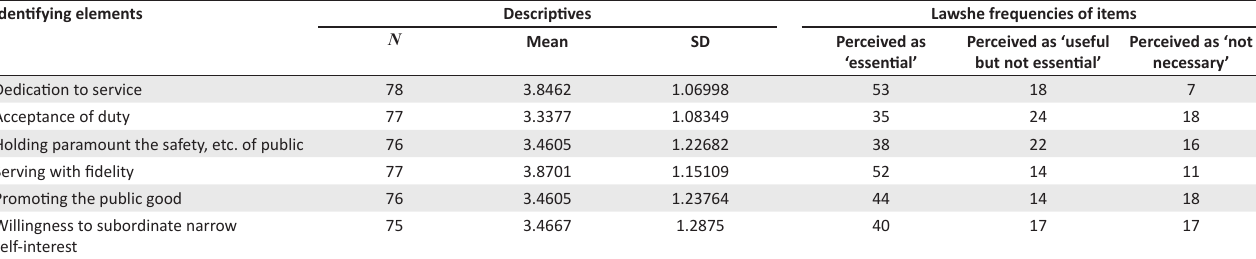
TABLE 11: Descriptive statistics of responsibility towards the public or society. Identifying elements